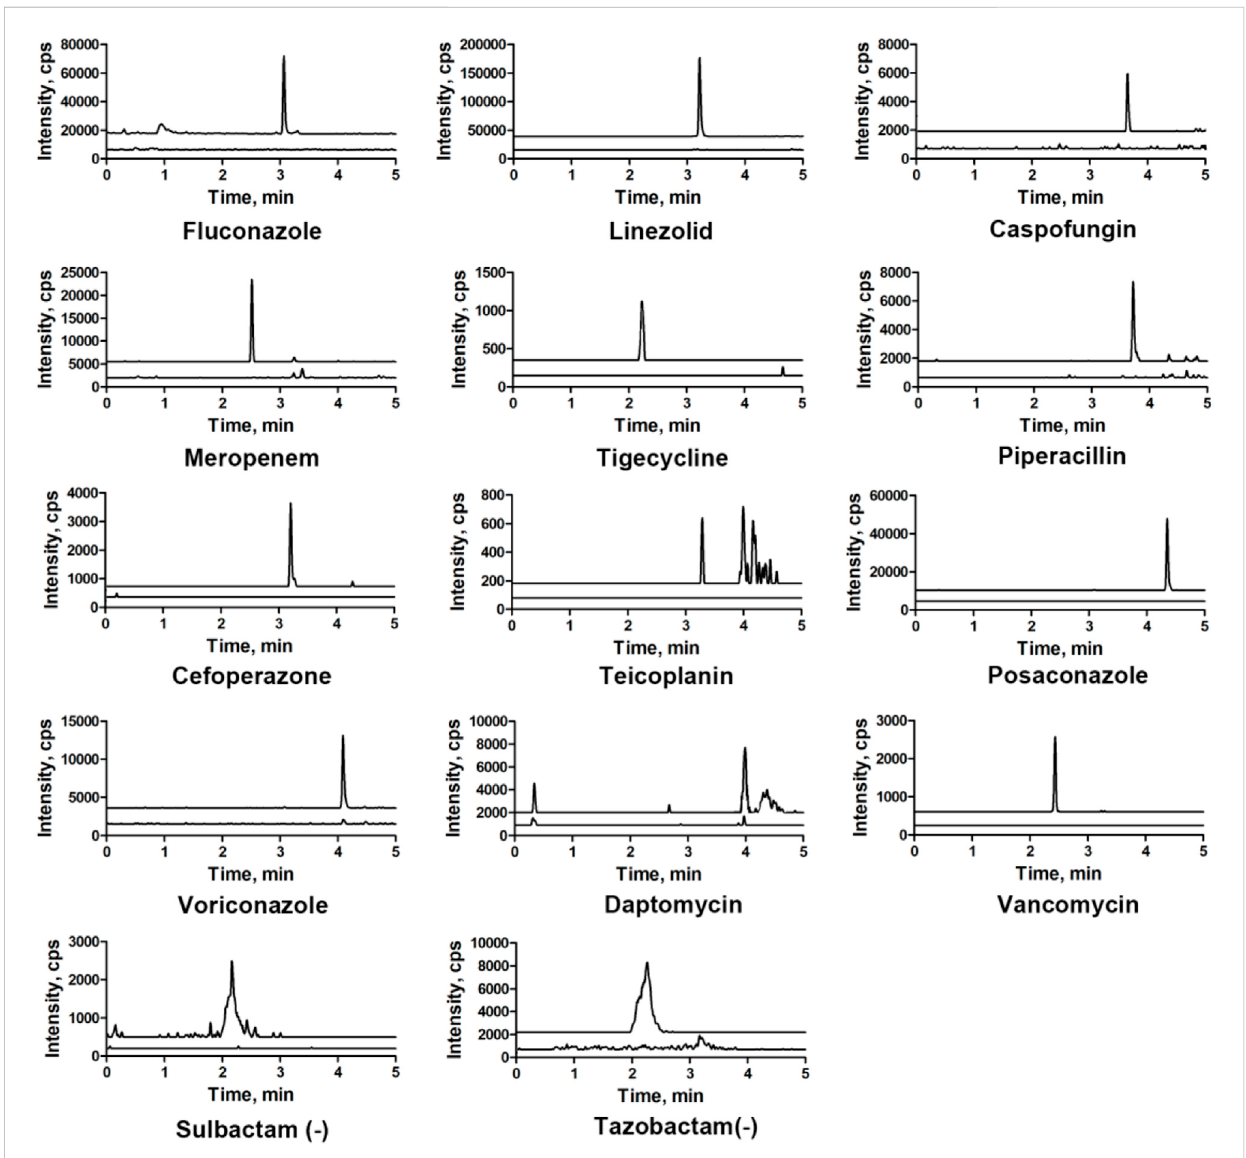
FIGURE 3 Overlapping of the LLOQ and blank-extracted chromatograms of 14 antibacterial agents.